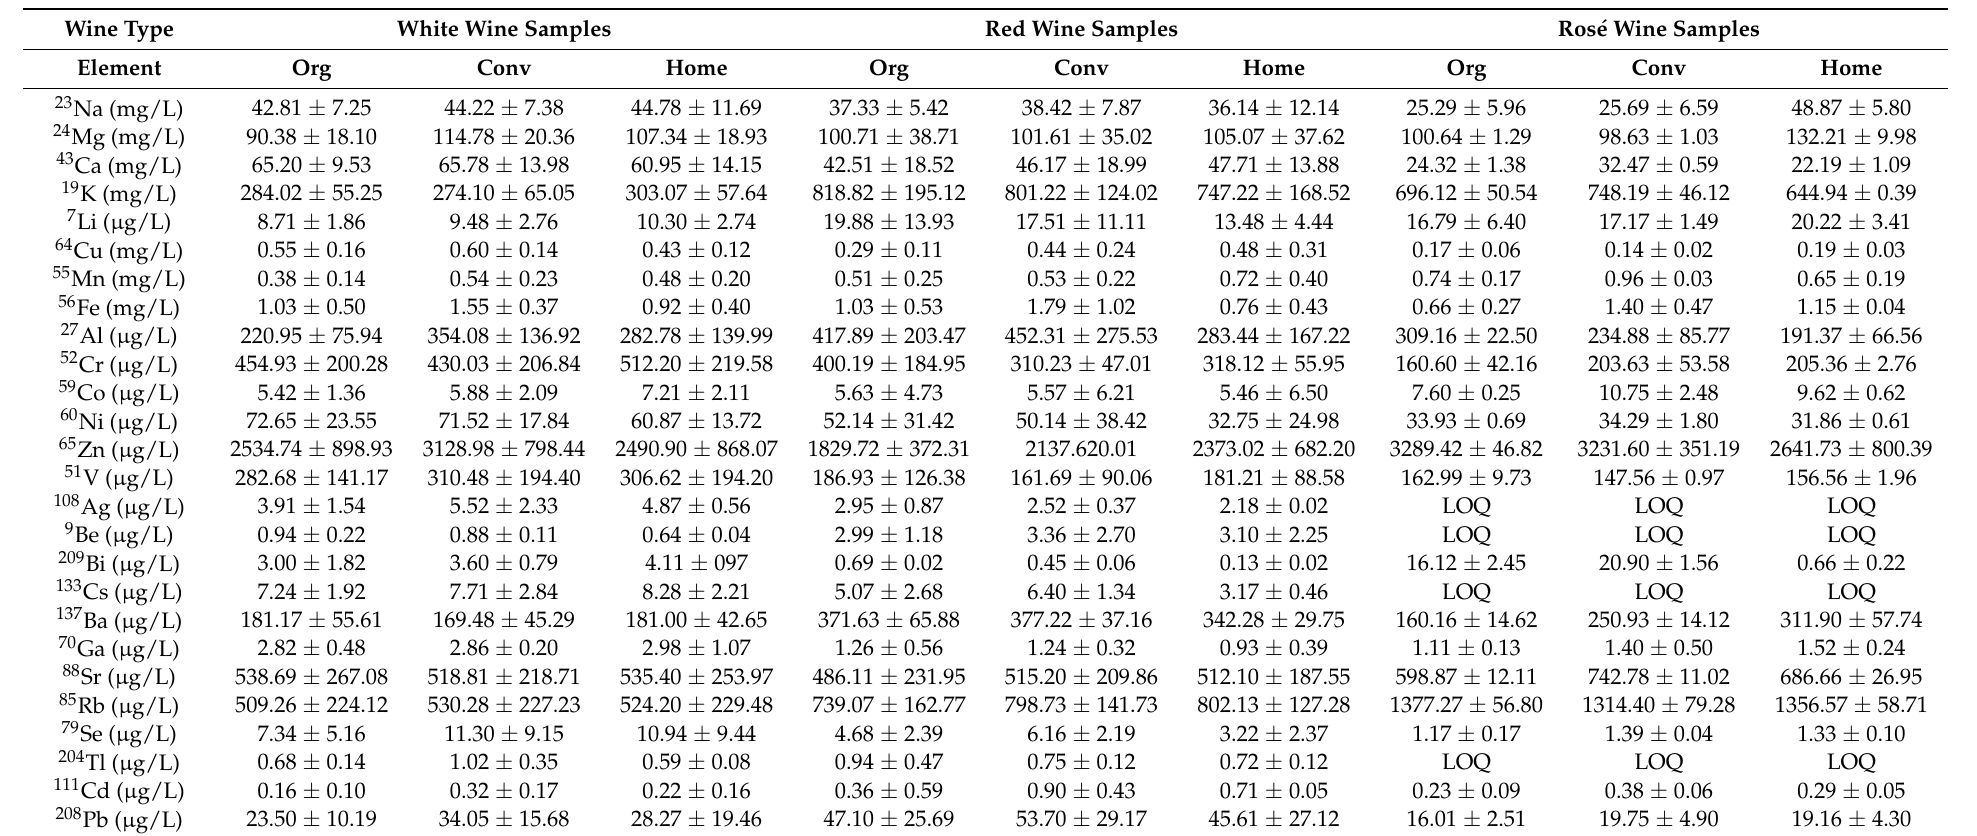
Table 3. Concentration (mean ± standard deviation) of elements in analyzed white, red, and ros é wines prepared under organic, conventional, and homemade culture